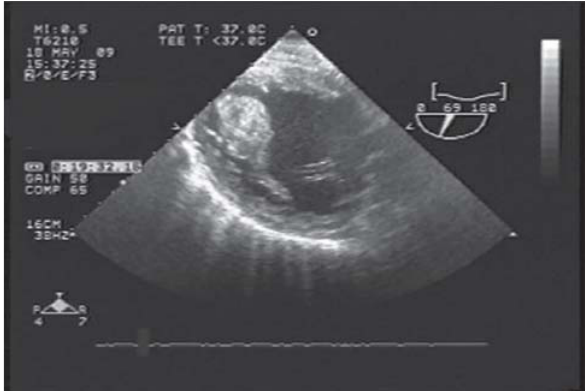
Fig. 1 - Transgastric long axis view shows the mass entrapped between papillary muscles